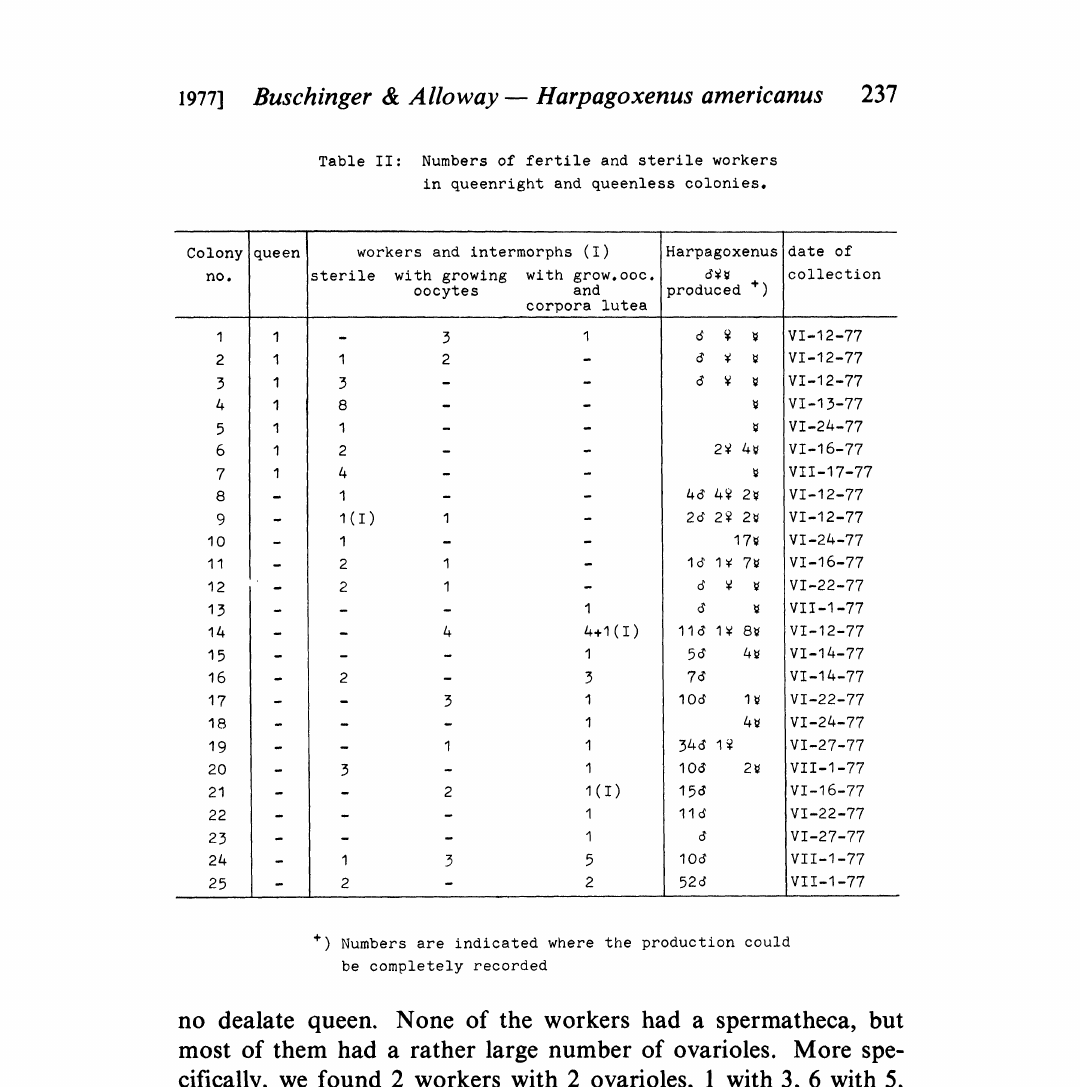
queen workers and intermorphs (I) Harpagoxenus Colony no. sterile with growing with grow. ooc. oocytes